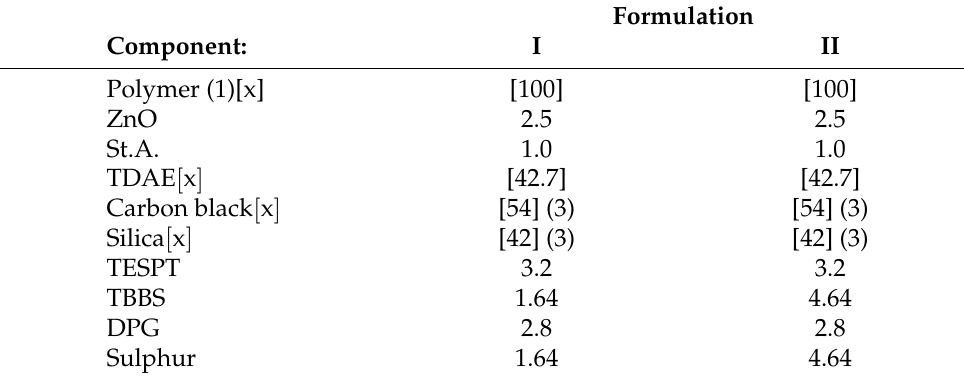
Table A3. Re-vulcanization formulations for a silica and carbon black containing de-vulcanizate, derived from a silica based tread formulation, values in